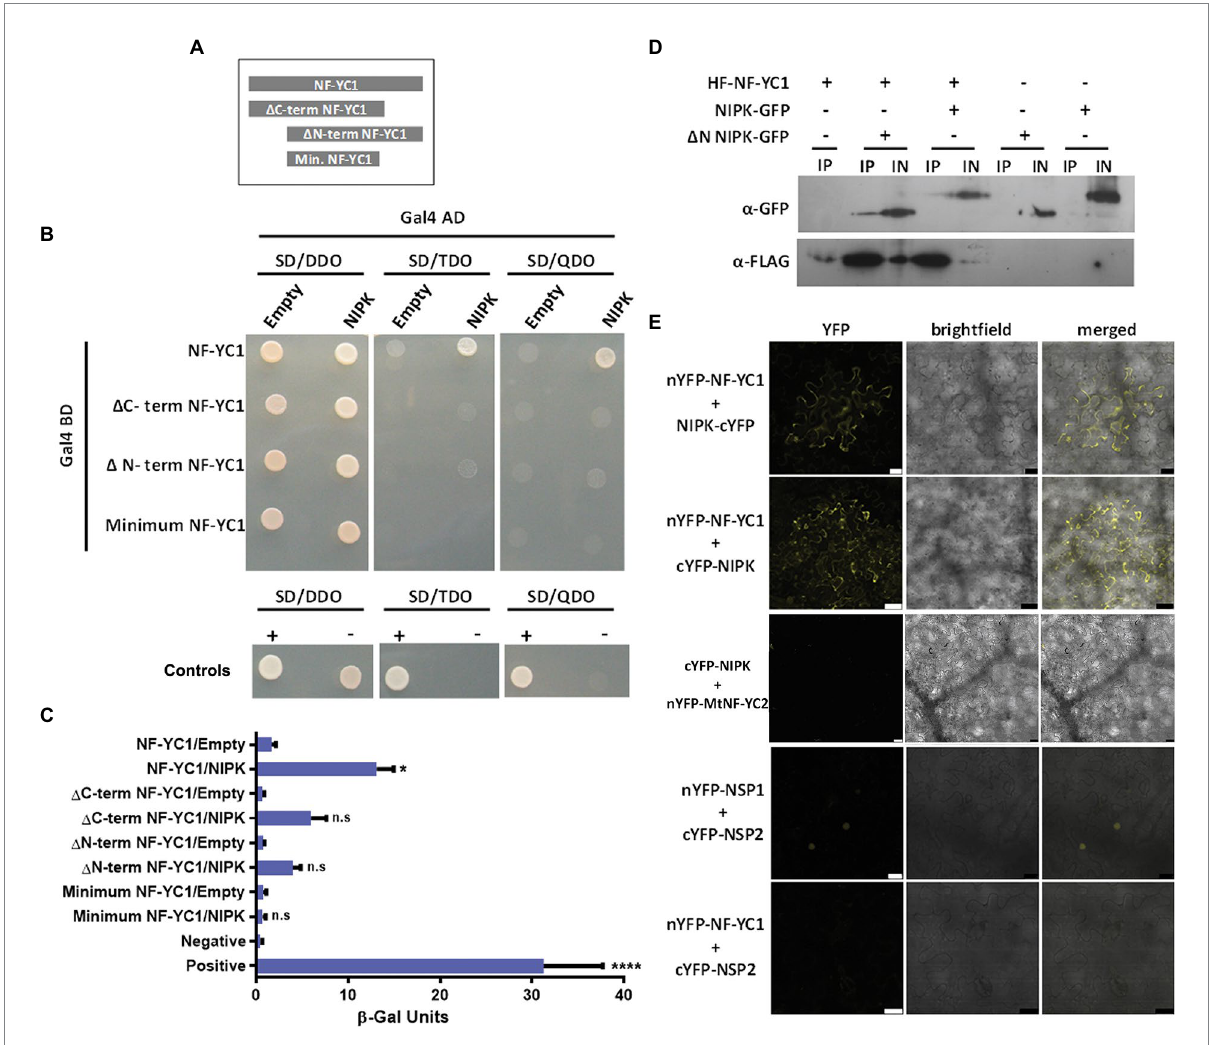
FIGURE 2 NIPK interacts with NF-YC1 in yeast and in planta. (A) Scheme of NF-YC1 versions used as baits in a yeast two-hybrid assay. (B) Interaction in yeast using the two-hybrid system. The pGBKT7 plasmid containing the Gal4 BD was fused to NF-YC1 or different truncated versions indicated in panel (A) and introduced into the Y187 strain. The pGADT7 plasmid containing the activation domain of Gal4 (AD) was fused to NIPK and introduced into the AH109 strain. The Y187 strains carrying the different versions of NF-YC1 were mated with the strain AH109 carrying the NIPK AD fusion or the empty vector. Strains were selected in synthetic defined media (SD) lacking leucine and tryptophan (double dropout, SD-DDO); leucine, tryptophan, and adenine (triple dropout, SD-TDO) or leucine, tryptophan, adenine, and histidine (quadruple dropout, SD-QDO). Positive and negative controls are p53 interacting with AgT and LamC, respectively. (C) The interaction was quantified using a β -Galactosidase assay with ONPG as substrate. Bars represent the media and SEM of three independent experiments. Asterisks indicate significant differences with the control in an ANOVA test followed by a Tukey test for multiple comparisons (*, p < 0.05; ****, p < 0.0001; ns, not significant). (D) Co-immunoprecipitation assay. His-FLAG tagged NF-YC1 (HF-NF-YC1) was co-expressed with the GFP tagged NIPK (NIPK-GFP) or a truncated version lacking the N-terminus transmembrane domain (GFP- ∆ N NIPK) in Nicotiana benthamiana leaves. The crude extract or input (IN) and the fraction immunoprecipitated with FLAG antibodies (IP) were analyzed by Western blot using anti-GPF or anti-FLAG antibodies ( α -GFP and α -FLAG). (E) Bimolecular fluorescence complementation assay. Nicotiana benthamiana leaves were co-infiltrated with nYFP-NF-YC1 in combination with cYFP-NIPK, NIPK-cYFP, or cYFP- NSP2 (negative control). The interaction between Medicago truncatula NSP1 and NSP2 is shown as a positive control. Confocal laser microscopy images of the YFP fluorescence (left panels), bright field (middle panel), and merged (right panel) are shown. Scale bars: 50 μ